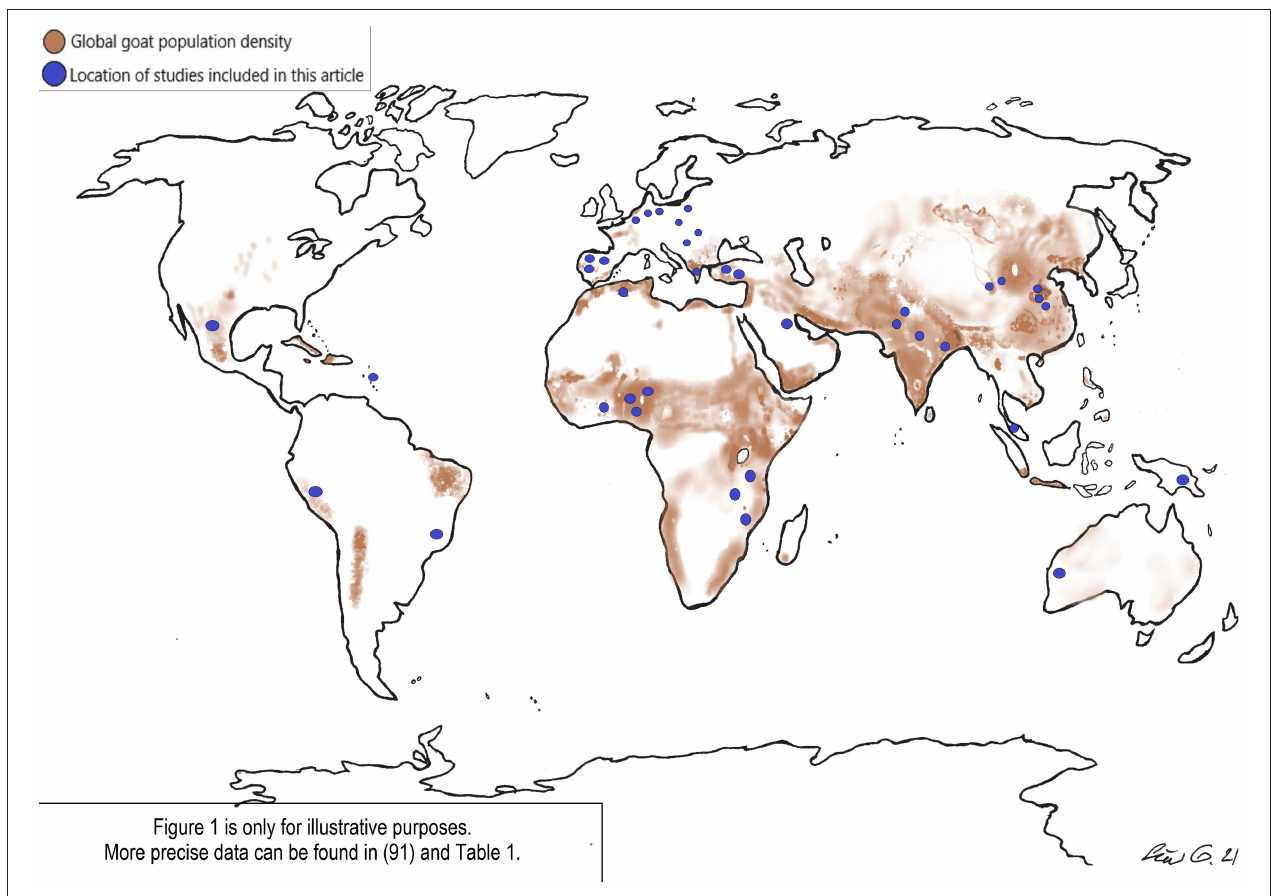
FIGURE 1 | Global goat distribution and locations of